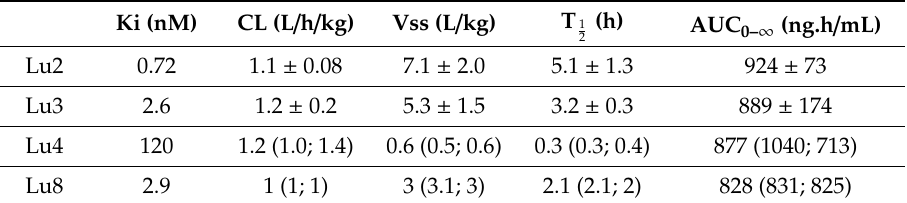
Table 5. Overview of PK parameters in rats after IV administration of 1 mg / kg test